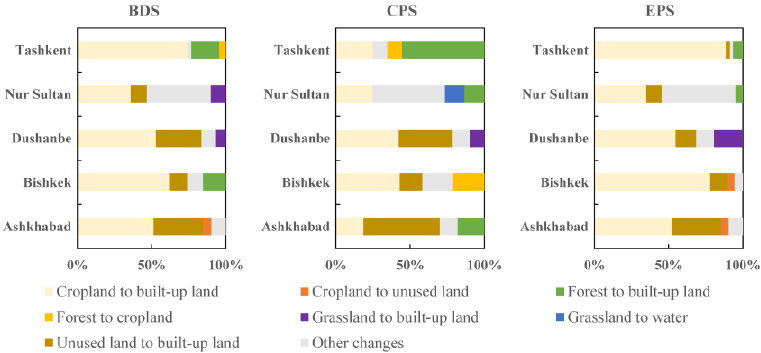
Figure 5. The percentages of carbon storage loss induced by land use change under three scenarios.